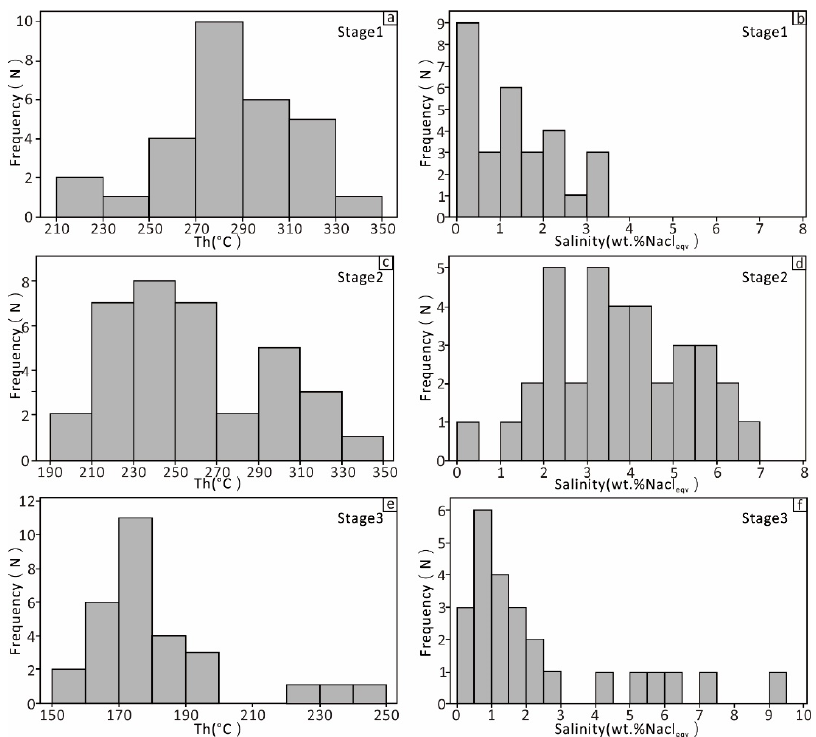
Figure 7. Histograms of the homogenization temperatures ( a , c , e ) and salinities ( b , d , f ) of the fluid inclusions in the Xialiugou deposit.